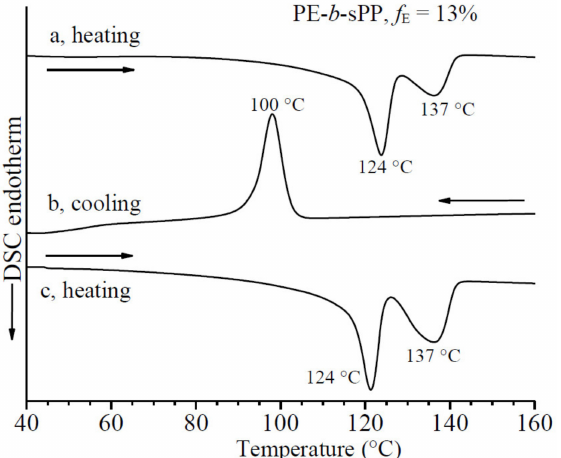
Figure 3. DSC thermograms of the sample PE- b -sPP with f PE = 13% recorded at scanning rate of 10 ◦ C/min during heating of the as-prepared sample (a), cooling from the melt to room temperature (b) and successive heating of the melt-crystallized sample